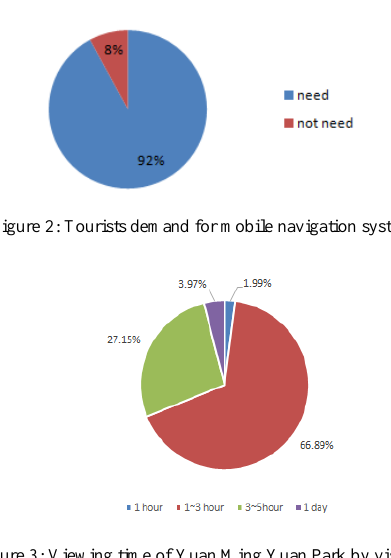
Figure 3: Viewing time of Yuan Ming Yuan Park by